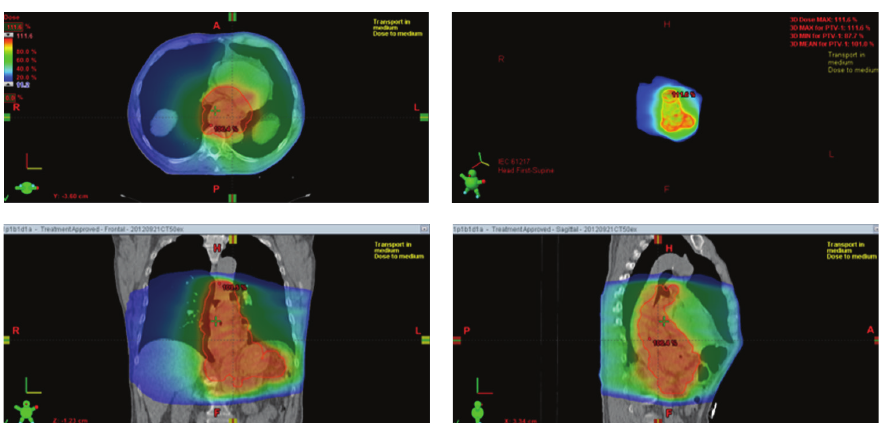
Figure 1: Images of radiation field showing embedding of the anterior wall of the descending aorta and of the